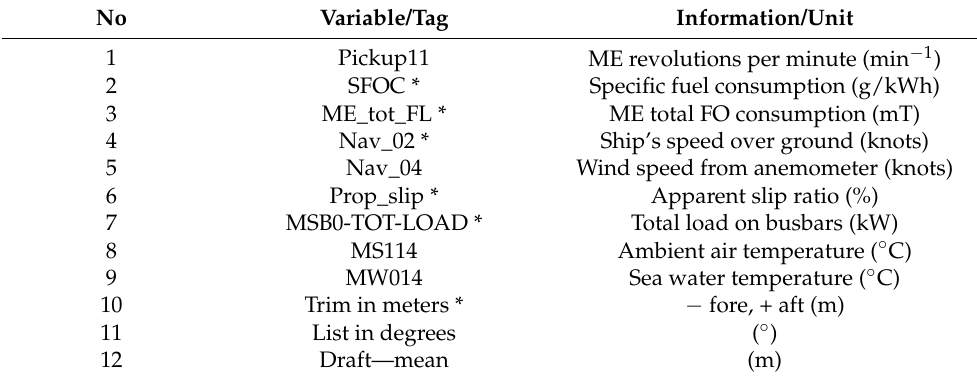
Table 2. List of sensors/tags from the ship automation system.